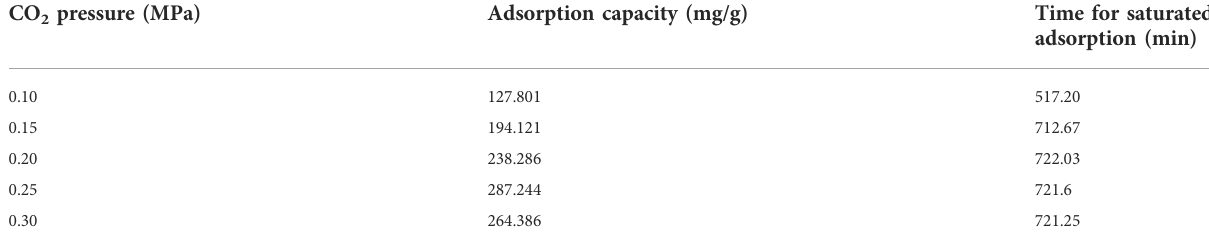
TABLE 2 Adsorption capacity and time for saturated adsorption of silica gel prepared at different CO 2 pressures at a relative humidity of 50%